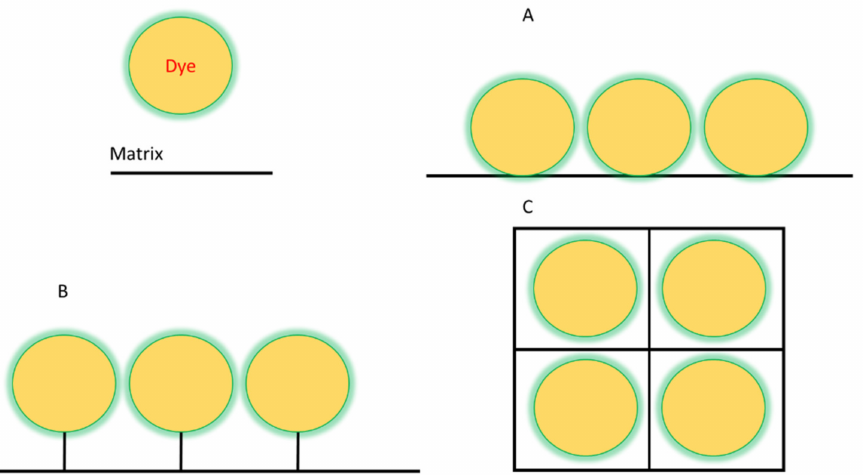
Figure 1. Scheme of the various dye immobilization methods: ( A )—adsorption, ( B )—covalent binding, ( C